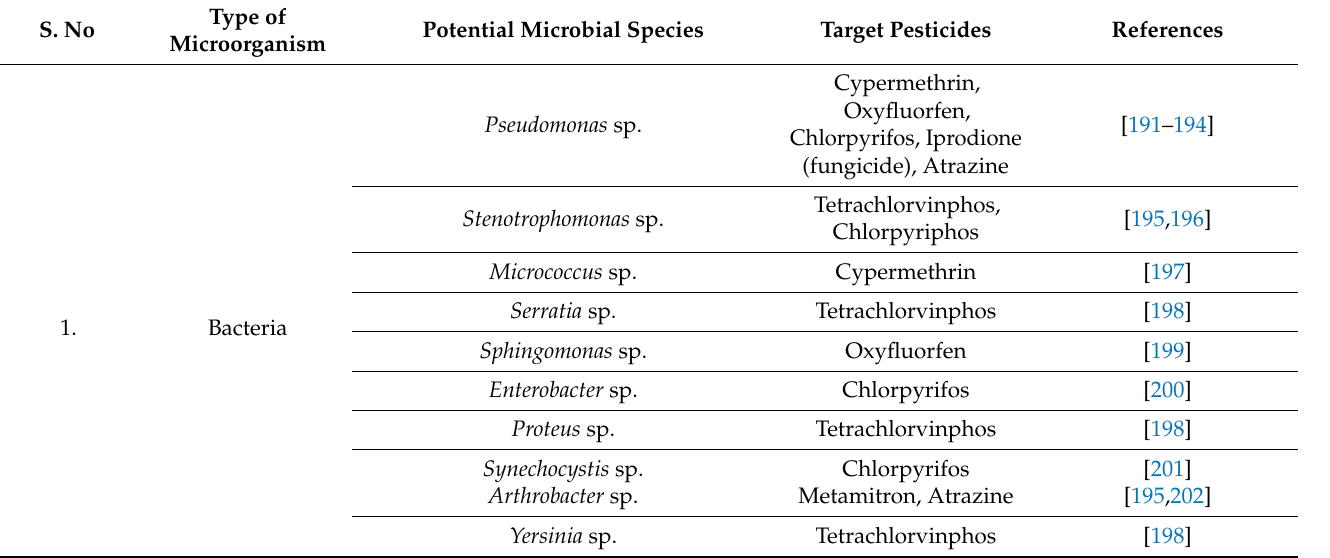
Table 2. Microbial remediation of pesticide-contaminated